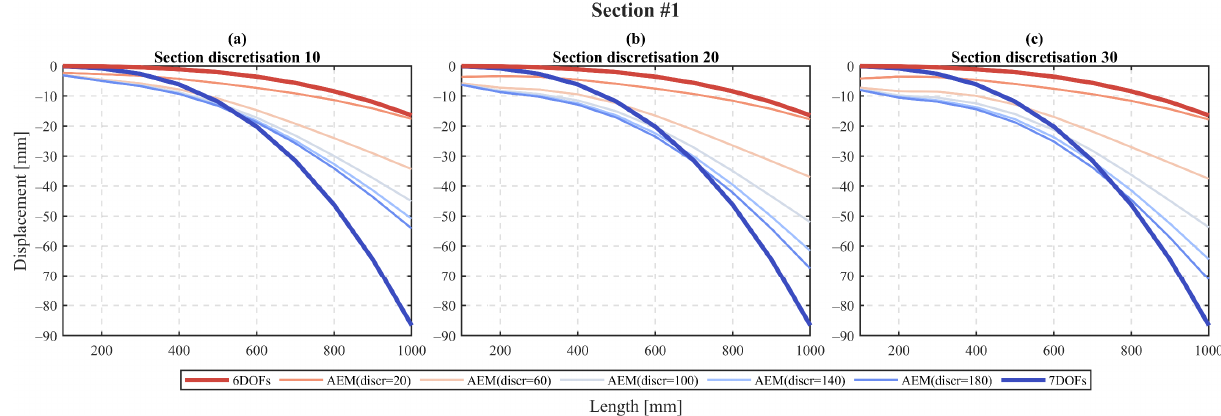
Figure 4. Vertical displacement–length relation for Section #1 with the different discretisation configurations.